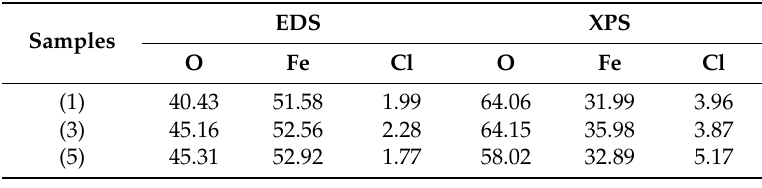
Table 2. Atomic percentages (a i ) of O, Fe, and Cl obtained by EDS and XPS measurements in samples (1), (3), and (5).